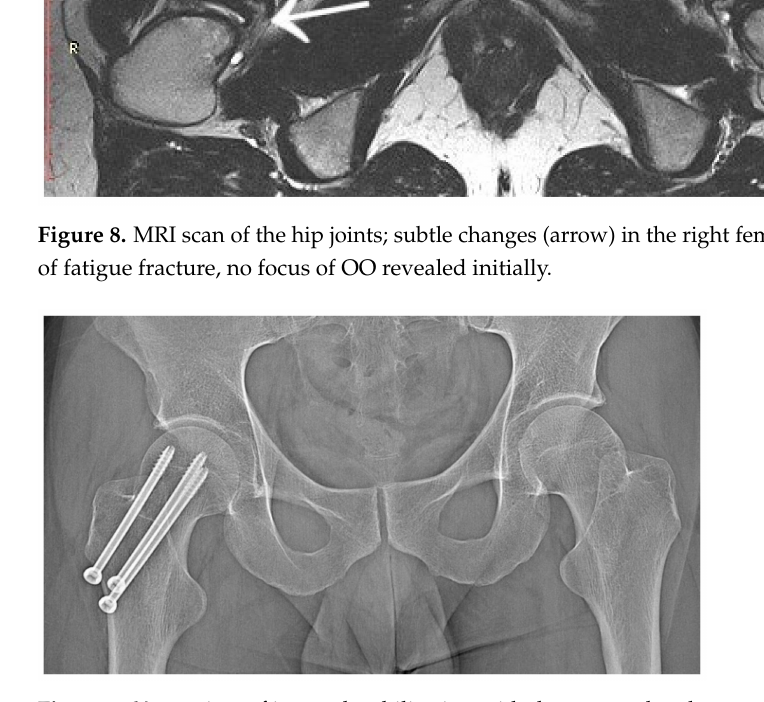
Figure 9. X-ray view of internal stabilisation with three cannulated screws of the right femoral